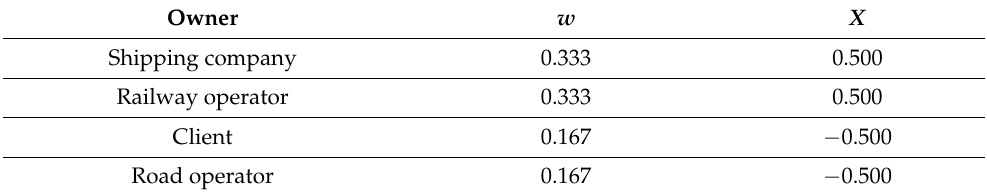
Table 9. Ranking of container owner according to retention